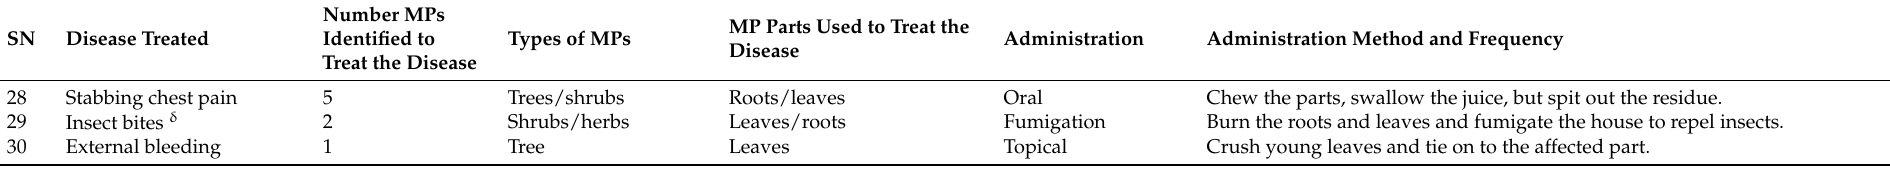
Table 2. Medicinal plants identified and the administration method used to treat animal diseases and manage insect infestations, recorded in the study FDGs.